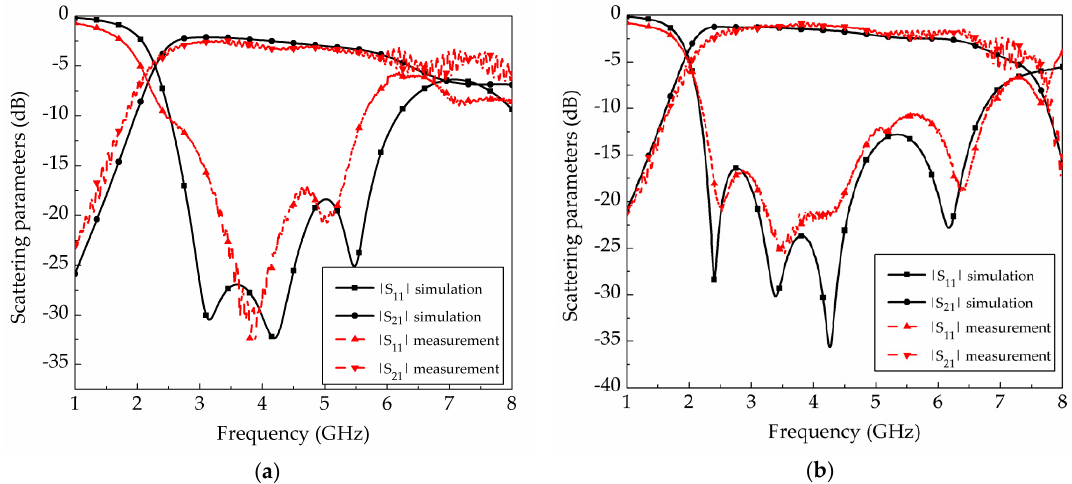
Figure 11. Simulated and measured results of SIWs: ( a ) solid PLA; ( b ) honeycomb.